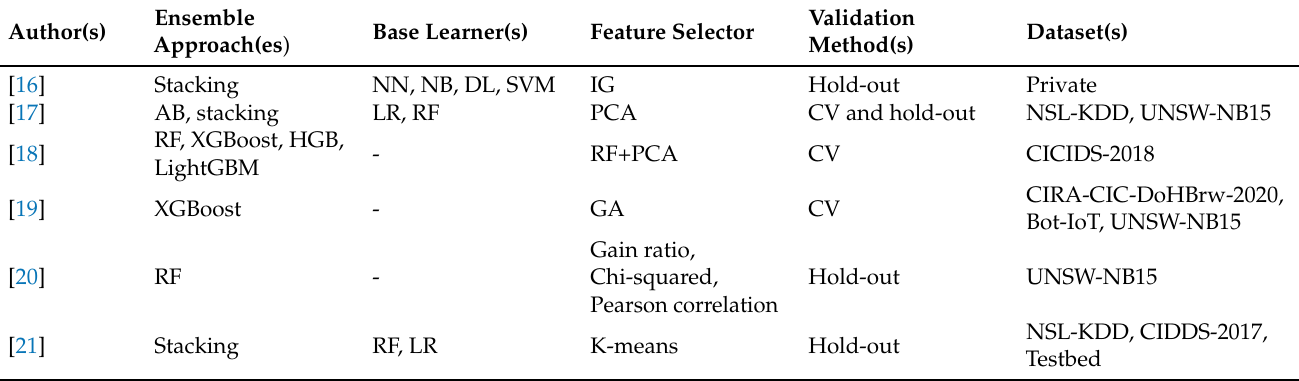
Table 1. Summarization of prior anomaly-based intrusion detection techniques that employ fea- ture selection and ensemble learning. The articles are chronologically ordered between 2020 and the